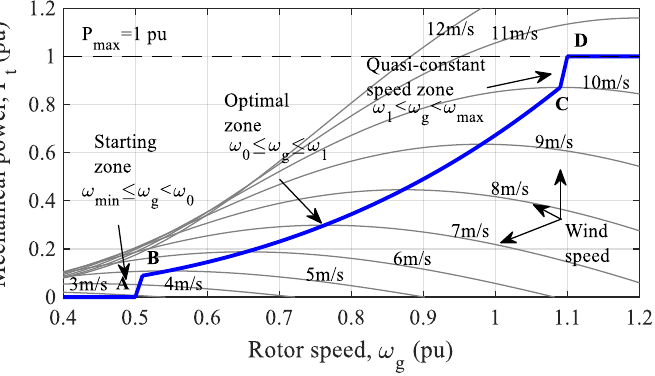
Figure 5. General scheme of the variable speed wind turbine.